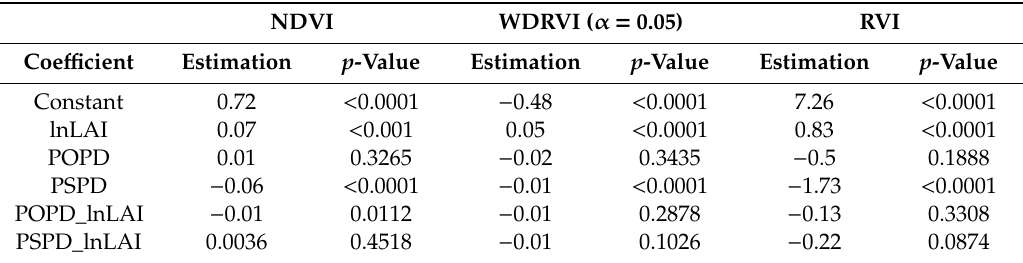
Figure 6. Logarithmic regressions of NDVI as a function of LAI including bare soil values, for VSPs with and without hail protection and different defoliation strategies: ( a ) UOPD—unprotected overall progressive defoliation (same curve presented in Figure 5a, this figure was included to aid with the comparisons), ( b ) POPD—protected overall progressive defoliation, and ( c ) PSPD—protected stepwise progressive defoliation. Bars indicate one standard deviation of the canopy NDVI values of each sample. Table 4. Logarithmic regression parameter estimations and significance for all data, separated with auxiliary variables and unprotected canopy values as the reference.